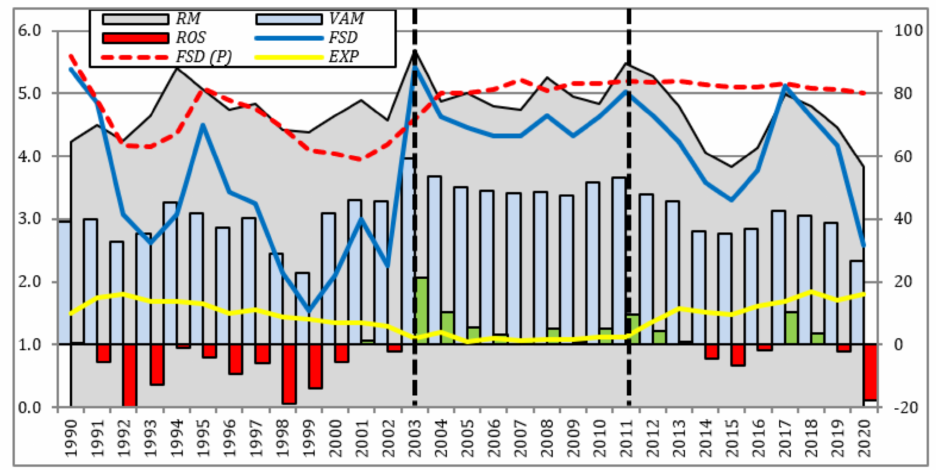
Figure 5. Restructuring measure ( RM ), ROS , export ( EXP ), VAM and financial security degree ( FSD ) for coal mining companies in 1990–2020. Note: RM —standardised values, left axis. FSD (P) —financial security degree for production enterprises. Other categories—right axis (%). Source: as in Figure